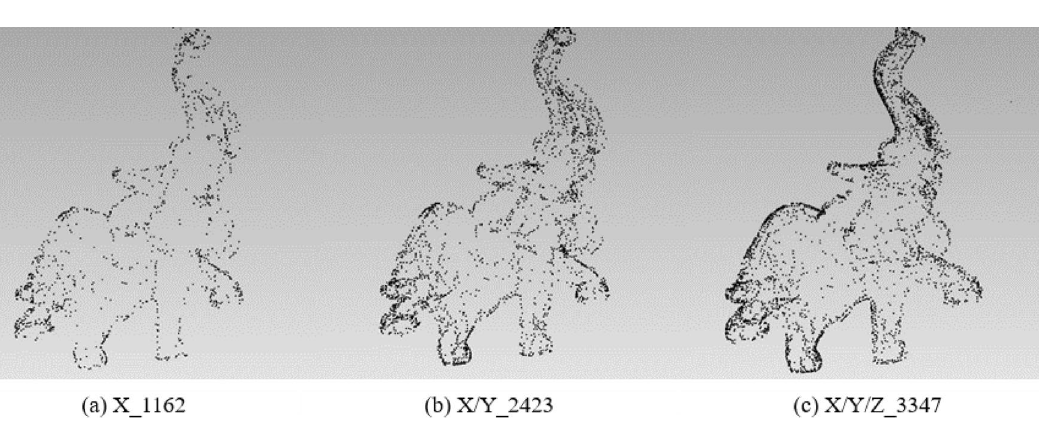
Figure 3. The point cloud with different numbers of feature points extracted with different axes for